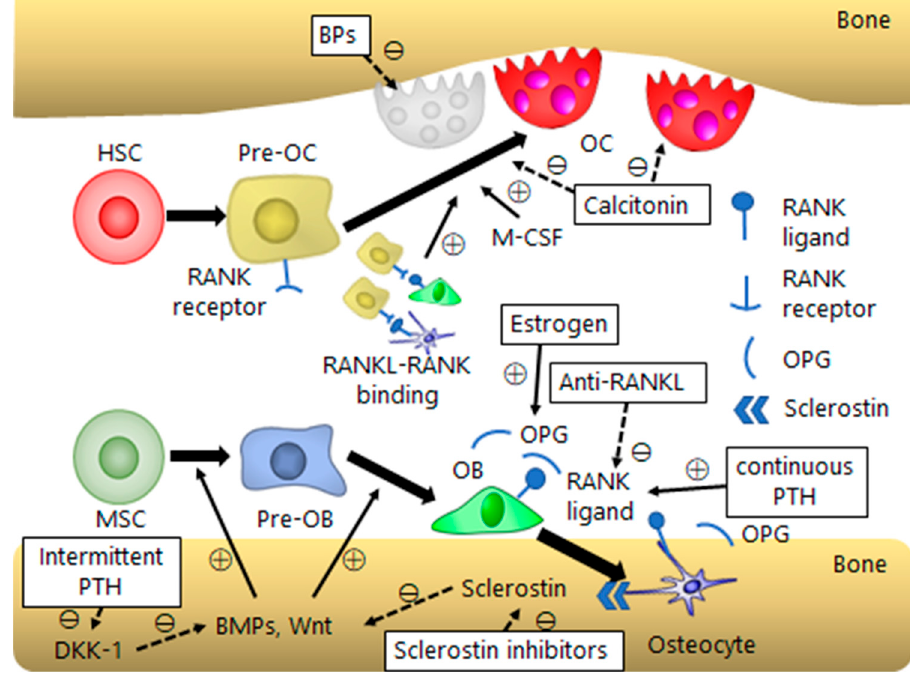
Figure 1. Schematic diagram of bone homeostasis and a summary of the action mechanism of the agents for osteoporosis. BP, bisphosphonate; DKK, dickkopf; M-CSF, monocyte / macrophage colony-stimulating factor; PTH, parathyroid hormone; normal arrows with “ + ” mean positive e ff ect; dotted arrows with “ − ” mean negative e ff ect. This figure is copyright free.